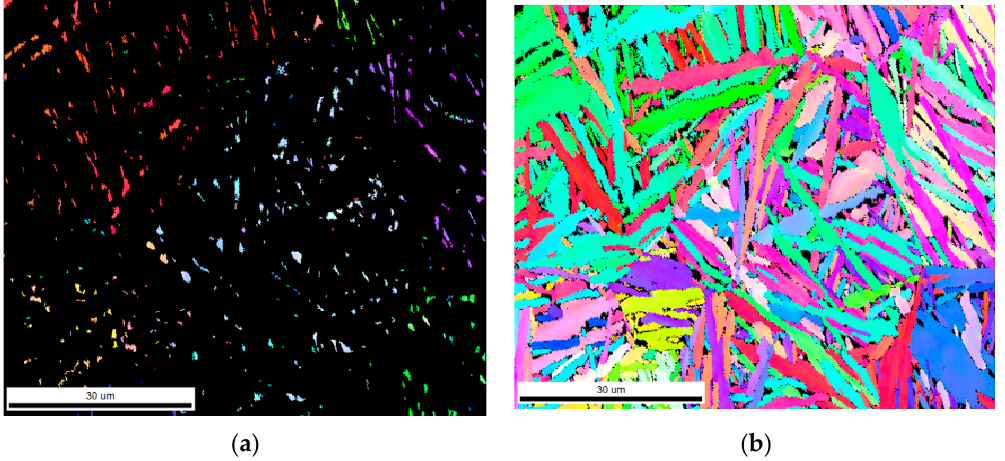
Figure 8. EBSD inverse pole figure maps of AT specimen: ( a ) face ‐ centered cubic (FCC) and ( b ) body ‐ centered cubic (BCC).